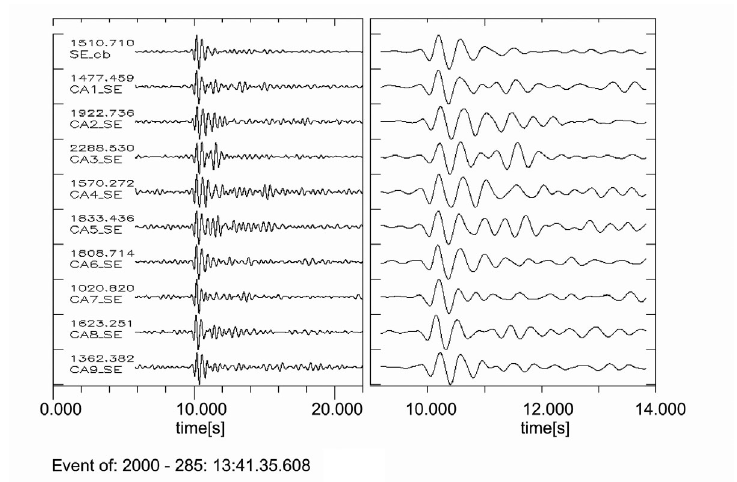
Fig. 10. The E-W component records (CA1_SE-CA9_SE) of the seismic event from fig. 7. The upper trace shows the S -beam calculated for the Sg -phase, after delaying the traces according to the apparent velocity and the backazimuth determined by the f - k analysis from fig. 11a. The right side shows a blow-up of the Sg -phase.